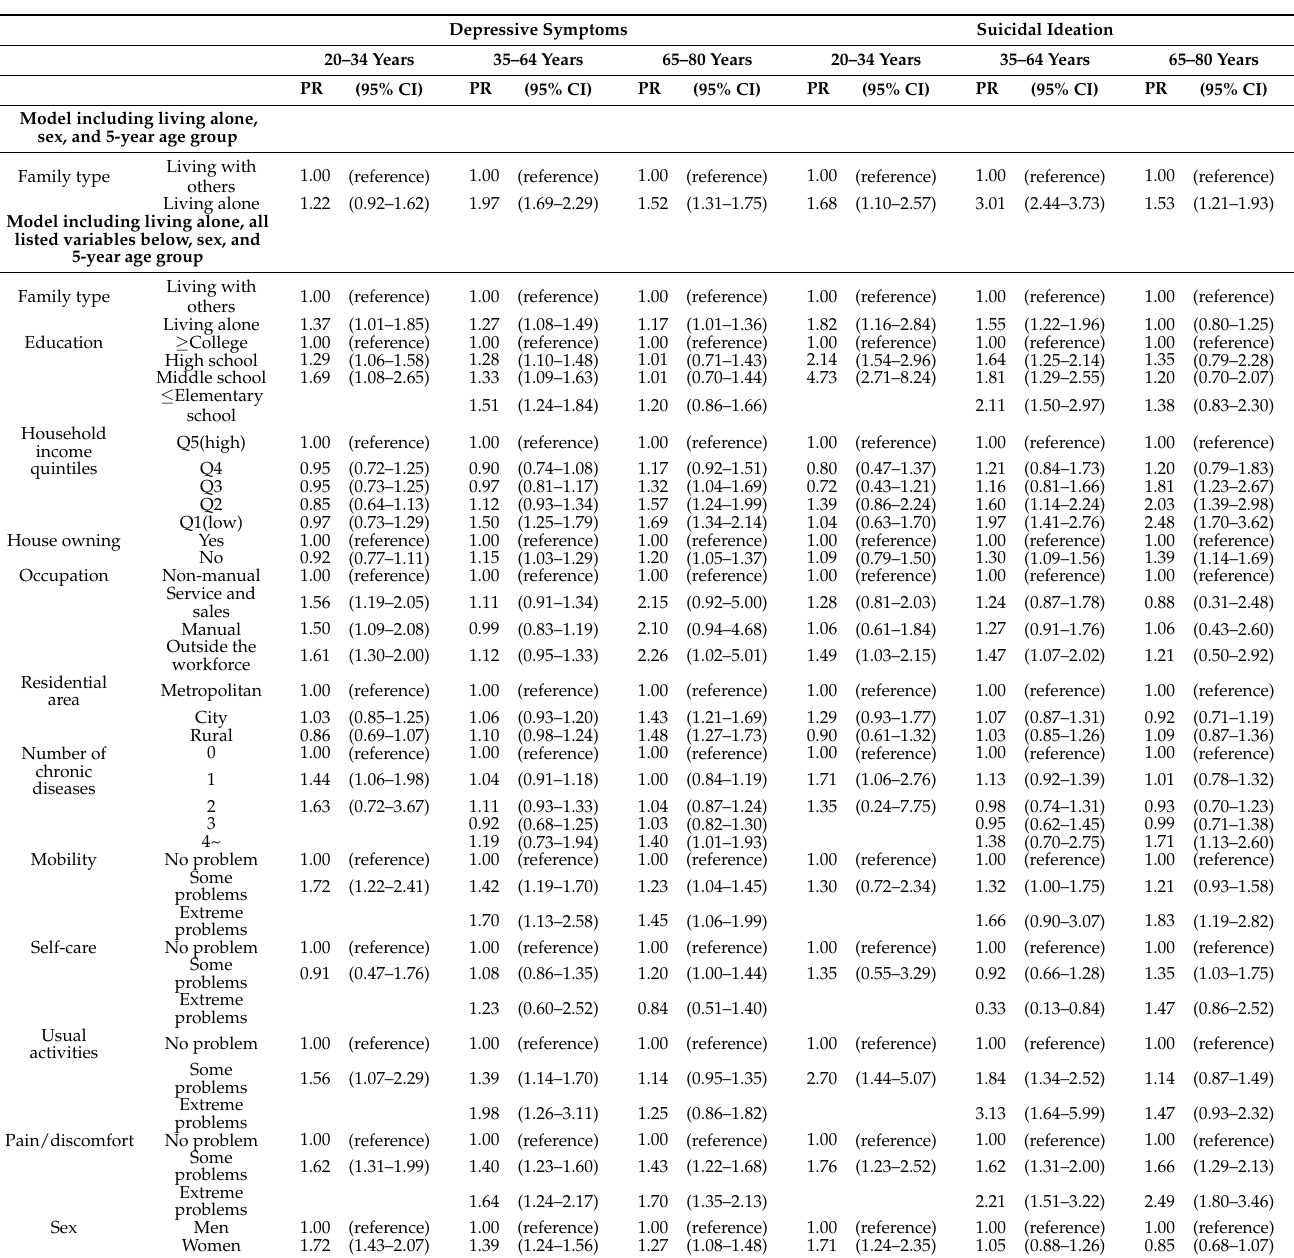
Table 4. Association between those living alone and sociodemographic factors and mental health by age